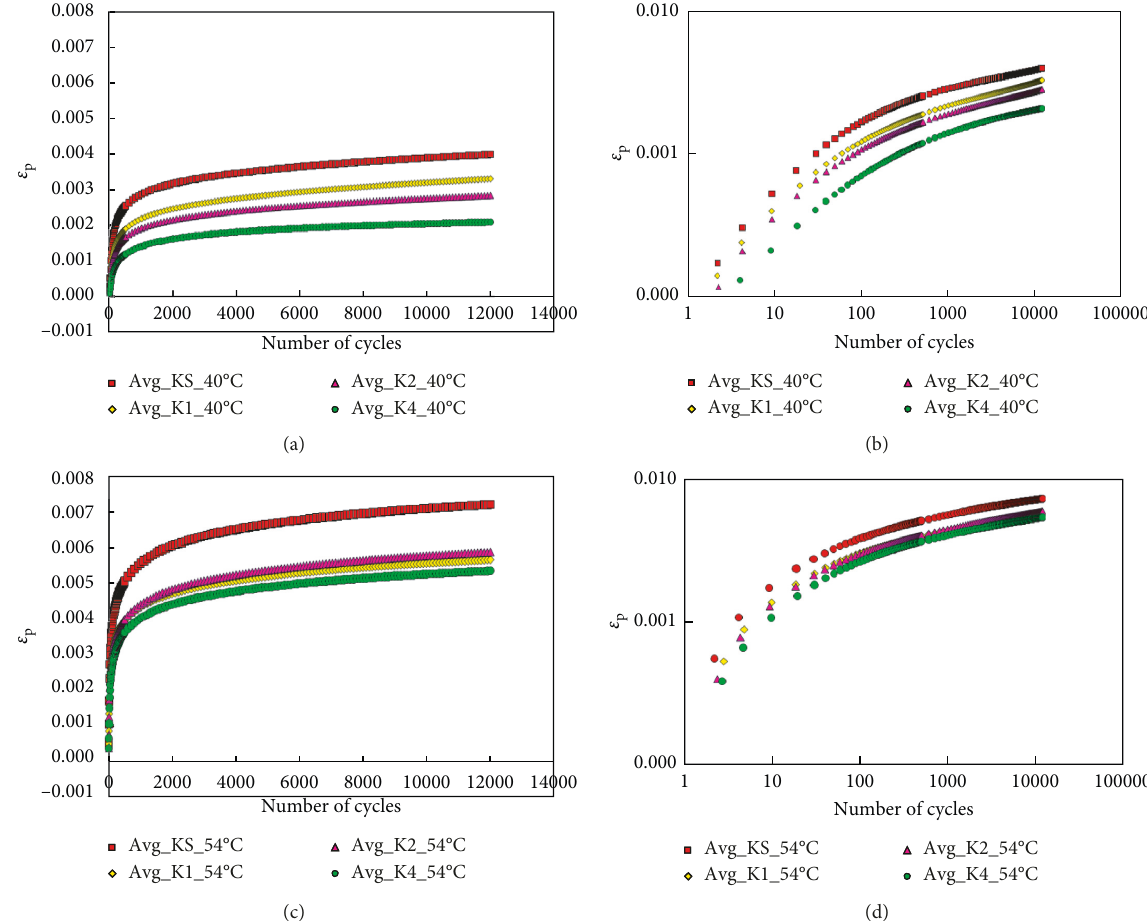
Figure 13: Comparison of permanent strain growth of the four mixtures: (a) at 40 ° C in arithmetic scale; (b) at 40 ° C in log-log scale; (c) at 54 ° C in arithmetic scale; (d) at 54 ° C in log-log